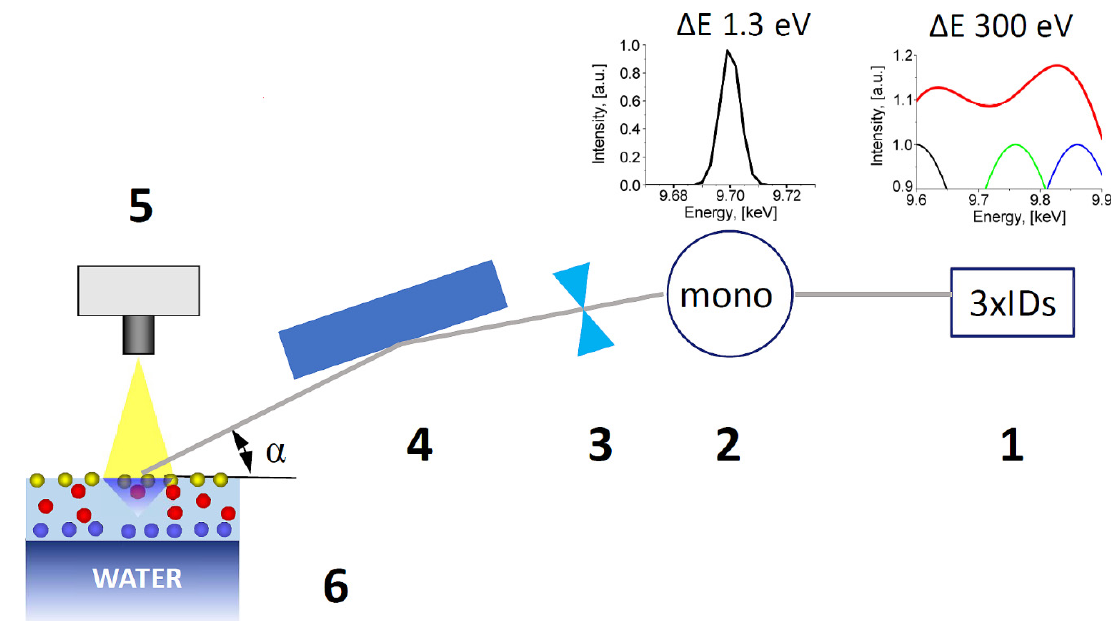
Figure 1. Schematic view of the X-ray absorption near edge structure (XANES) setup of the ID10 beamline at European Synchrotron Radiation Facility (ESRF). ( 1 ) Three undulators and corresponding energy spectrum produced by them; ( 2 ) Si(111) channel cut monochromator and the energy spectrum after it; ( 3 ) Compound refractive Be lenses for beam focusing on the sample; ( 4 ) Flat mirror deflecting the X-ray beam to the liquid surface below the critical of total reflection; ( 5 ) Energy dispersive Vortex EM detector; ( 6 ) Langmuir trough with the sample.